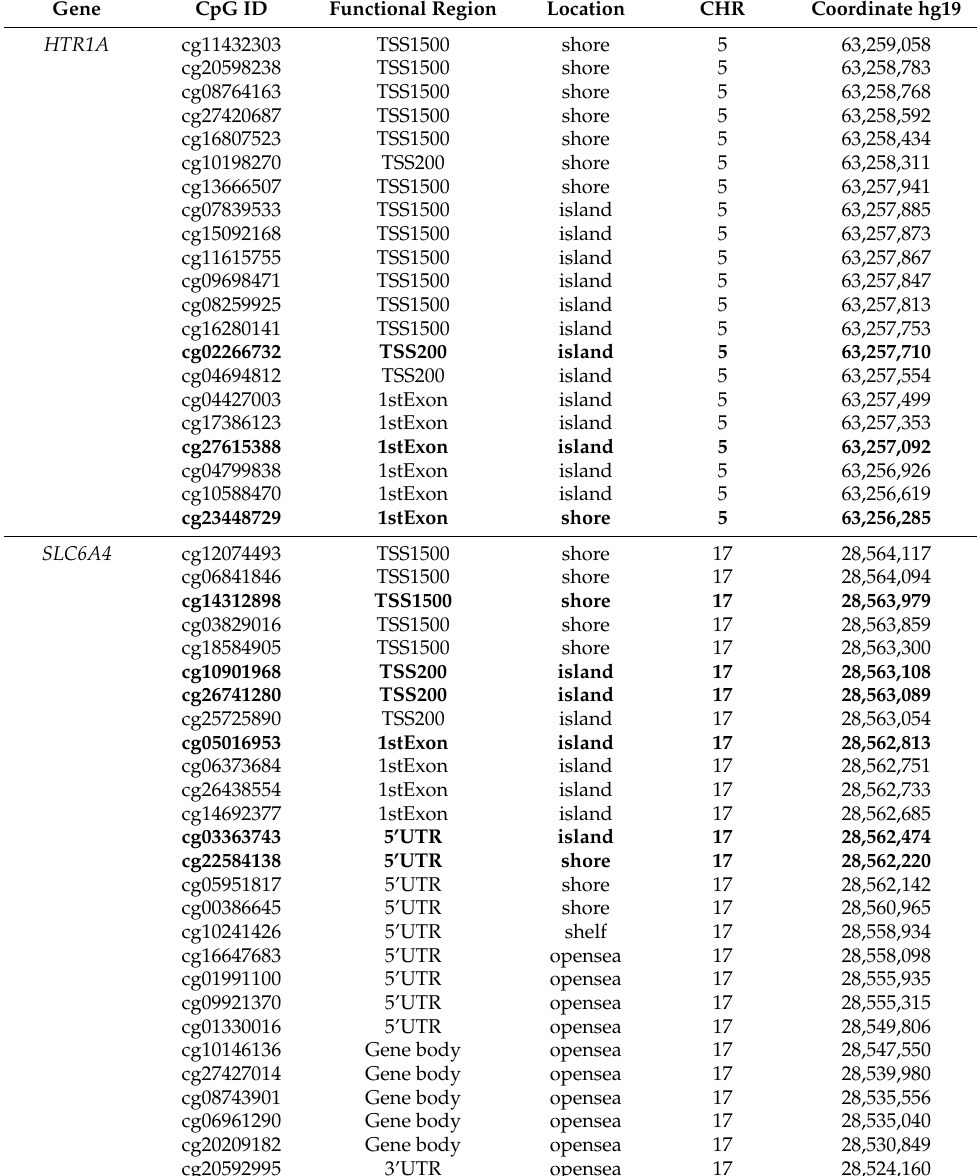
Table 2. 48 Chimpanzee serotonergic CpG sites identified and included in this study: 21 in the serotonin receptor gene 1A ( HTR1A ) and 27 in the serotonin transporter gene ( SLC6A4 ).